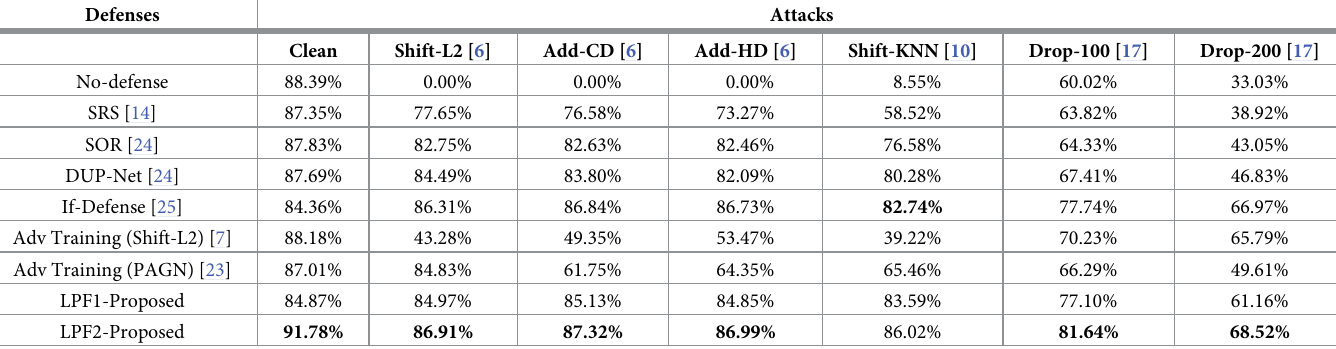
Table 1. Comparison of classification accuracy of proposed defenses with other defense strategies, under various attacks on PointNet and ModelNet40 datasets. Defenses